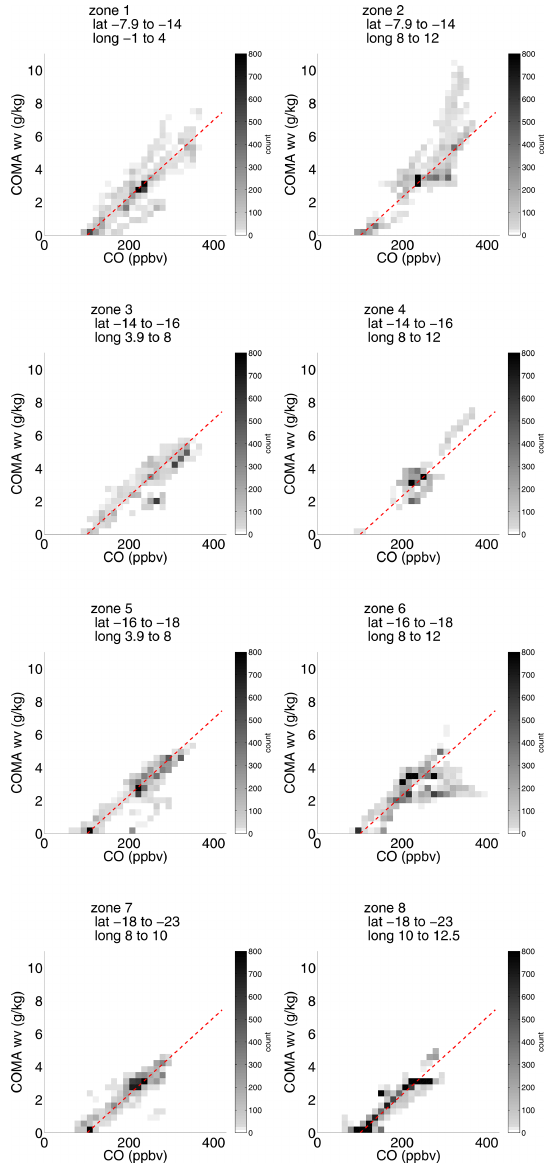
Figure 4. Frequency distribution (heat maps) of ORACLES-2016 specific humidity from COMA versus CO for z > 2km, subdivided zonally according to the boxes shown in Fig. 1. The dashed red line shows the fit through all 2016 data (as in Fig.